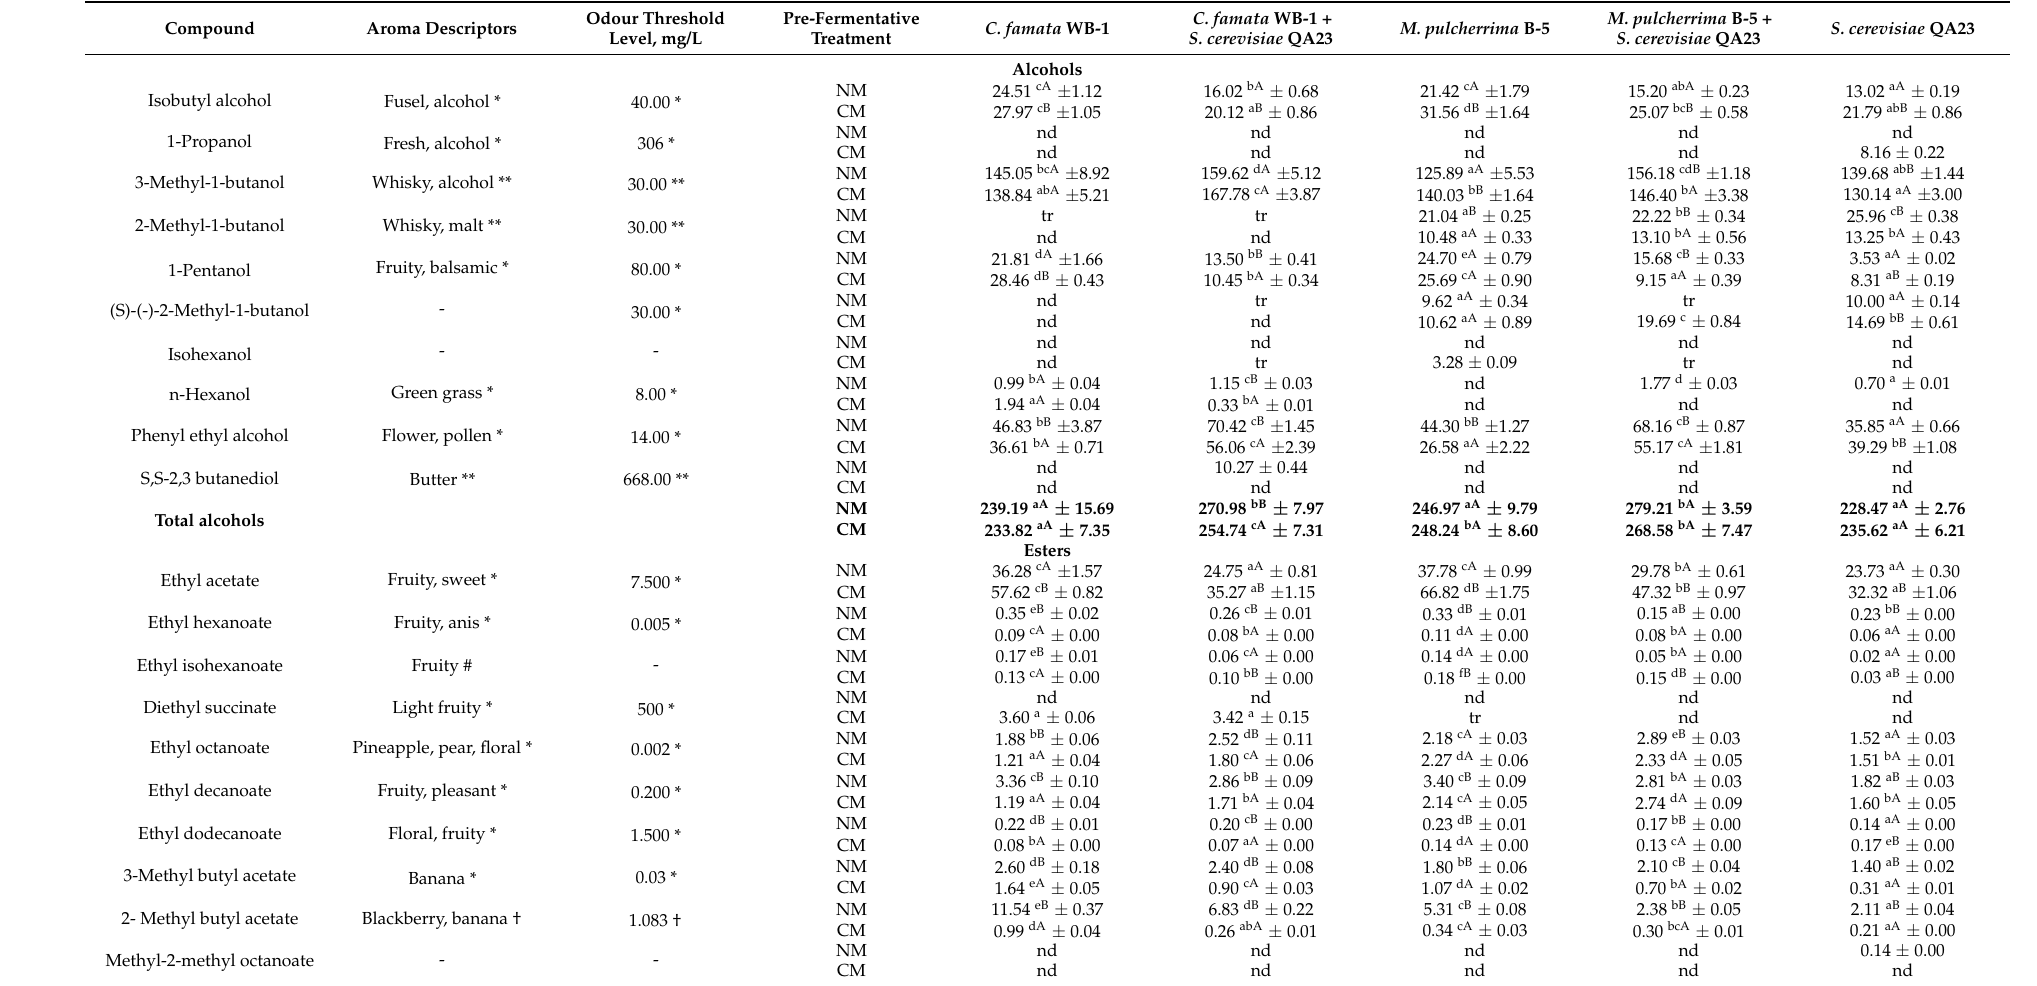
Table 2. Content of volatile compounds (mg/L) in wines produced with and without